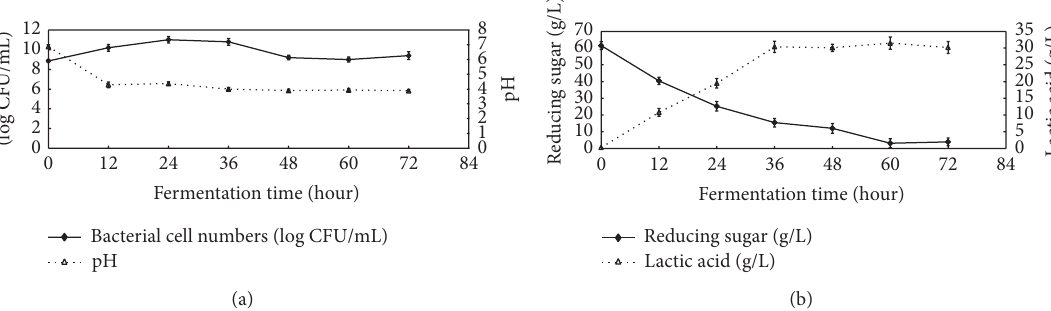
Figure 2: Changes in pH, lactic acid, cell numbers of L. pentosus L7, and reducing sugar in the fermenting liquid during decalcification of shrimp shells by L. pentosus L7.